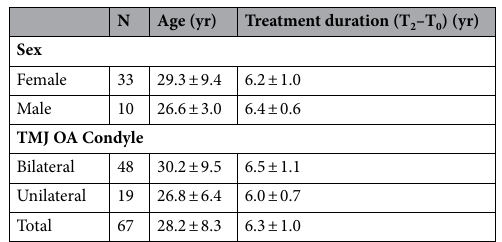
Table 3. Characteristics of the sample patients. Values are expressed as mean ± standard deviation. TMJ temporomandibular joint, OA osteoarthritis, yr